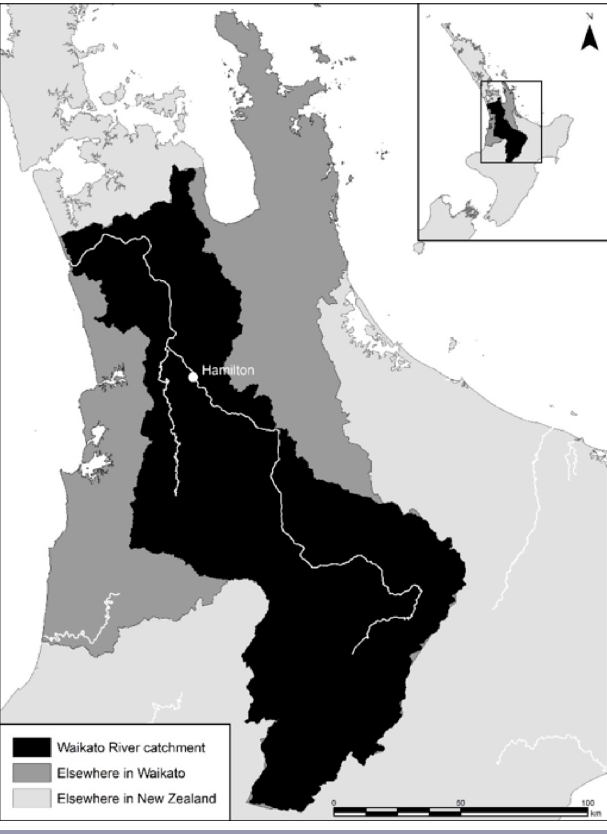
Fig. 3 . Northland. The Mangere, Waitangi, Doubtless Bay, Wh ā ng ā rei, and Pouto Lakes catchments are highlighted.